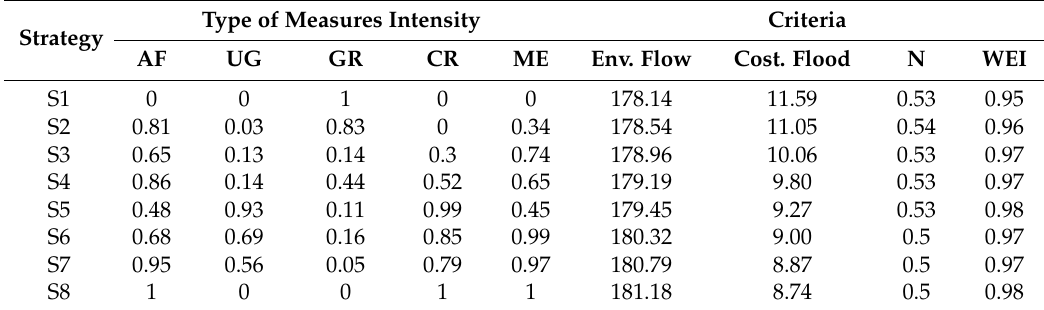
Table 6. Pareto PoM obtained according to N and Environmental flow criteria for the Iberian Peninsula region considering the flooding related family of correction measures (AF: afforestation, UG: urban greening, GR: grassland, CR: crop practices, ME: re-meander). Cost flood in 1000 € /km 2